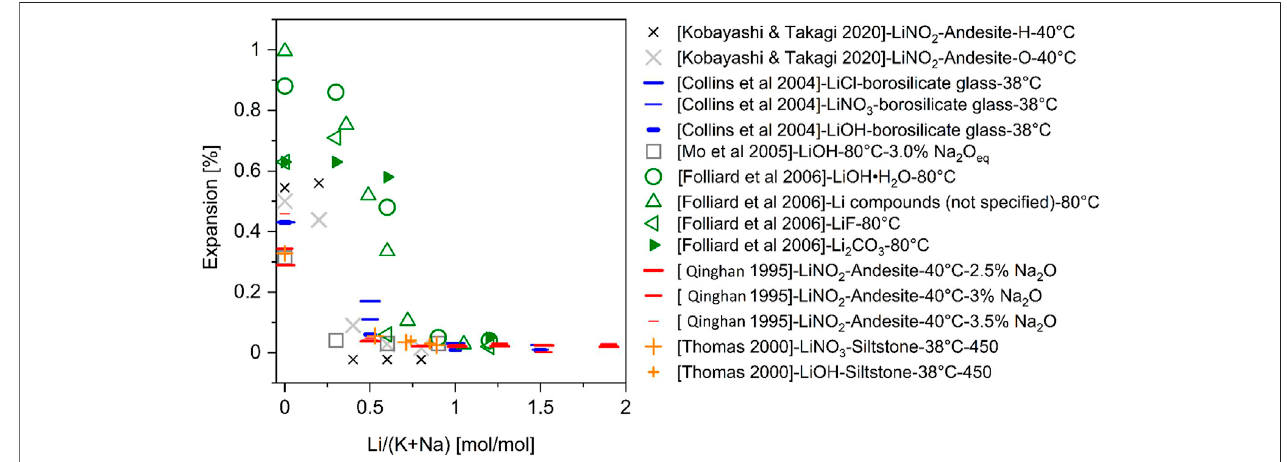
FIGURE 5 | Expansion measured over an extended time frame as it relates to the Li/Na ratio of the product for various lithium treatments (Qinghan et al., 1995; Thomas et al., 2000; Collins et al., 2004b; Mo et al., 2005; Folliard et al., 2006; Kobayashi amd Takagi, 2020).